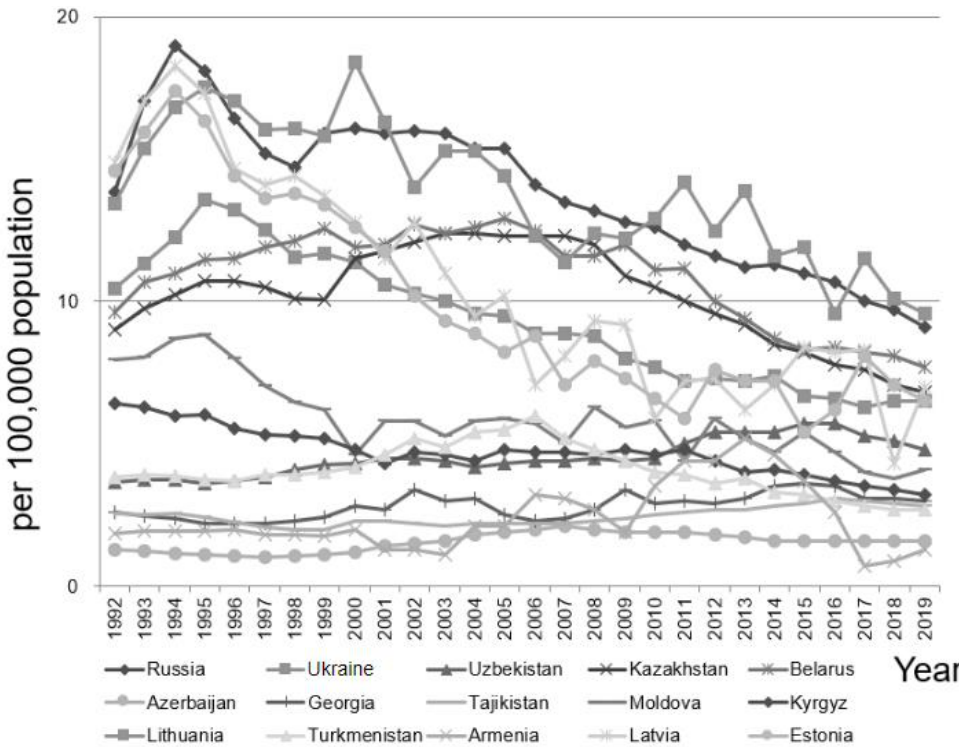
Figure 3. The annual suicide rate among females in the 15 post-Soviet countries in 1992–2019.